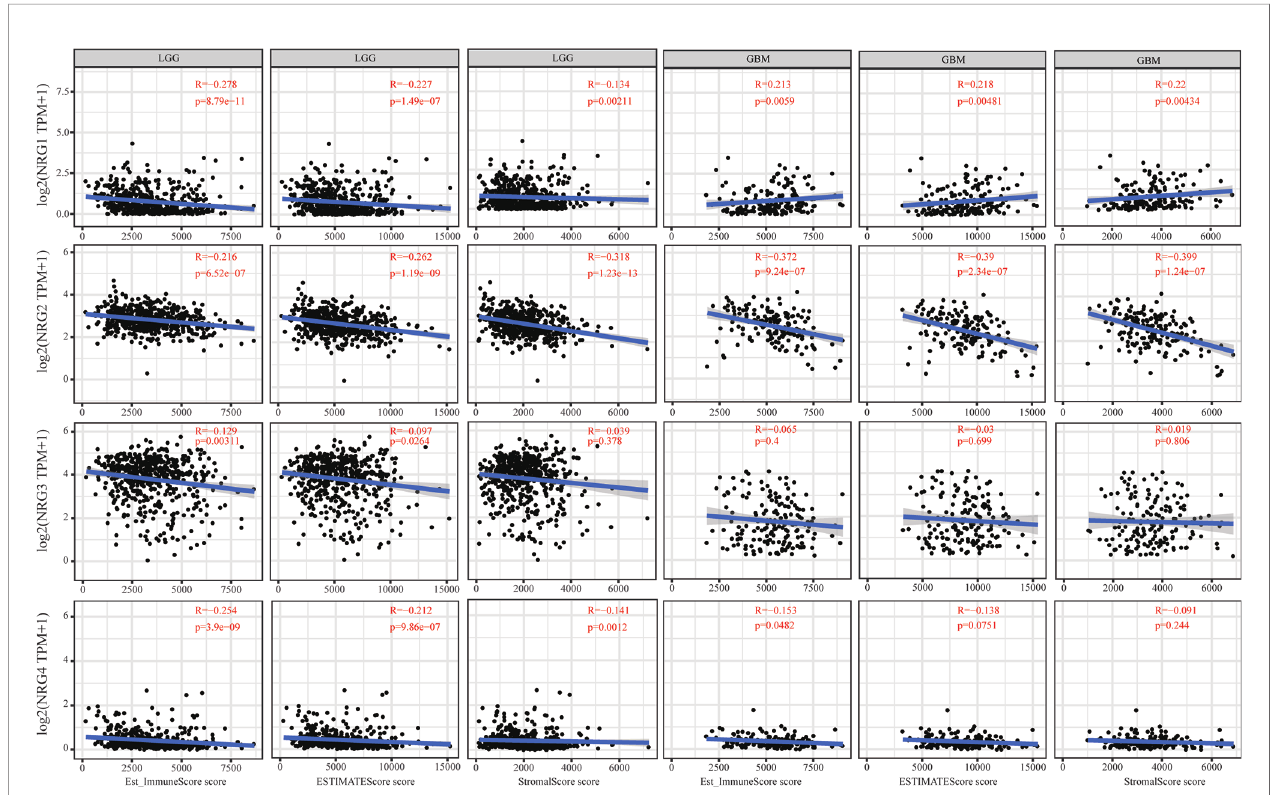
FIGURE 5 | Immune scores of NRGs in patients with LGG and GBM. Correlations between the immune score (ImmuneScore, ESTIMATEScore, and StromalScore) and the expression of NRG1-4 in LGG and GBM. Spearman ’ s correlation analysis was used to describe the correlation. P < 0.05 was considered statistically signi fi